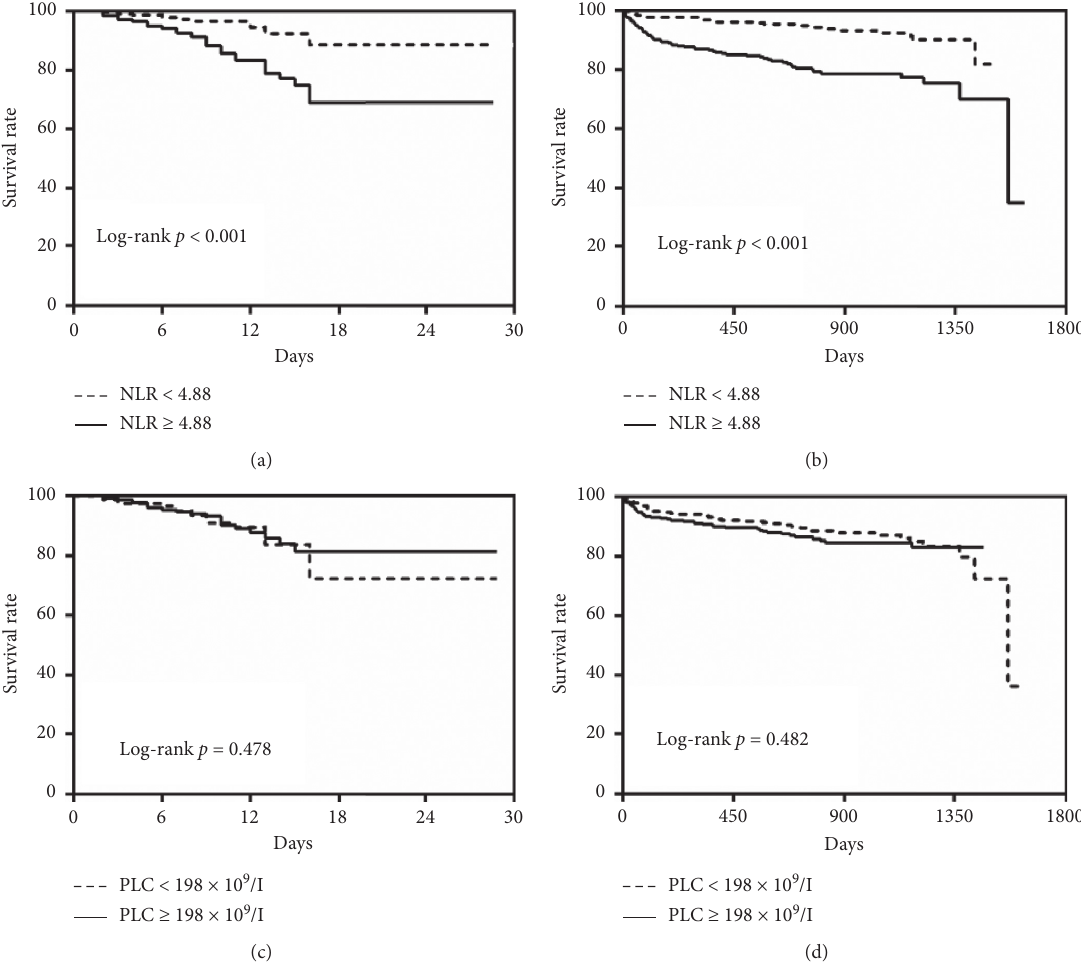
Figure 3: Kaplan–Meier survival curve of all-cause mortality based on the median value of NLR and PLC. (a) In-hospital mortality stratified by NLR. (b) Long-term mortality stratified by NLR. (c) In-hospital mortality stratified by PLC. (d) Long-term mortality stratified by PLC. Abbreviations: PLC, platelet count; NLR, neutrophil-to-lymphocyte